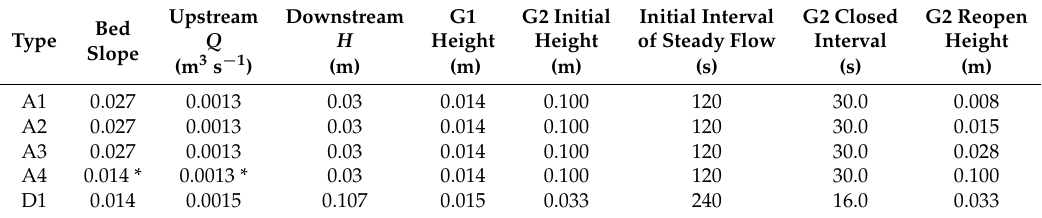
Table 2. Type A and Type D experiments reported in [35], as tested with PipeAC. Model downstream H is measured above the lowest point in the test pipe (not including buffer domain). * See discussion in text as how values for Q and bed slope were obtained for Case A4.